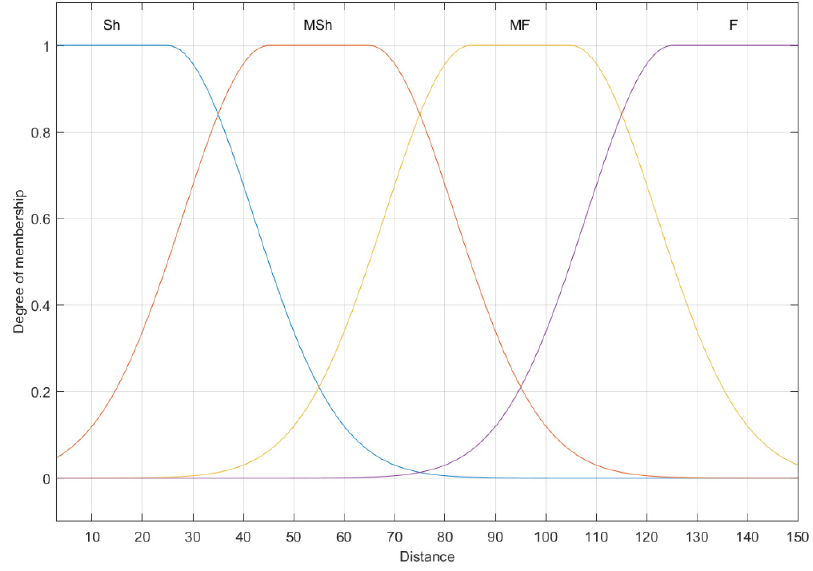
Figure 4. Fuzzy membership function for the first input distance (d). The Gaussian membership function was chosen for the second fuzzy input and the fuzzy output, named CSI and P rk , respectively. The ranges for CSI and P rk were set to [0 1] and [0.4 0.8], respectively. The five linguistic terms chosen to represent the universe of discourse for the CSI were: Very Weak (VW), Weak (W), Average (Av), Strong (St), and Very Strong (VSt), as shown in Figure 5. The mean values for the second fuzzy input CSI were as follows: Very Weak (VW) was set to [0], Weak (W) to [0.25], Average (Av) to [0.5], Strong (St) to [0.75], and Very Strong (VSt) was set to [1]. Again, the curve was designed based on the initial fixed Prk